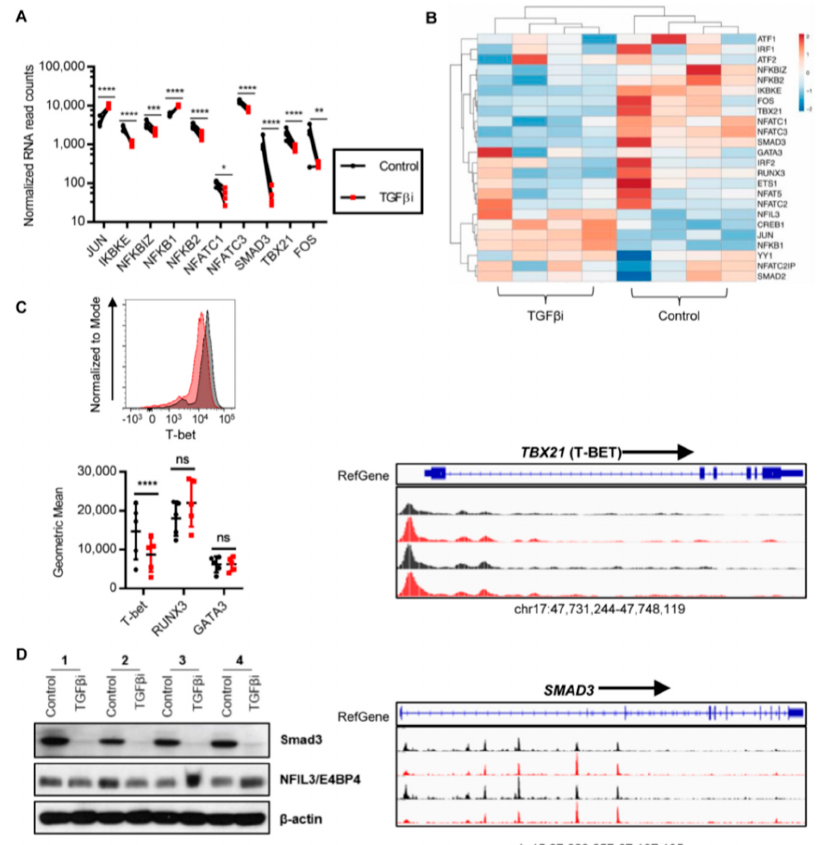
Figure 6. TGF β imprinting modifies the NK cell IFN γ regulation. See also Figure S4. ( A )